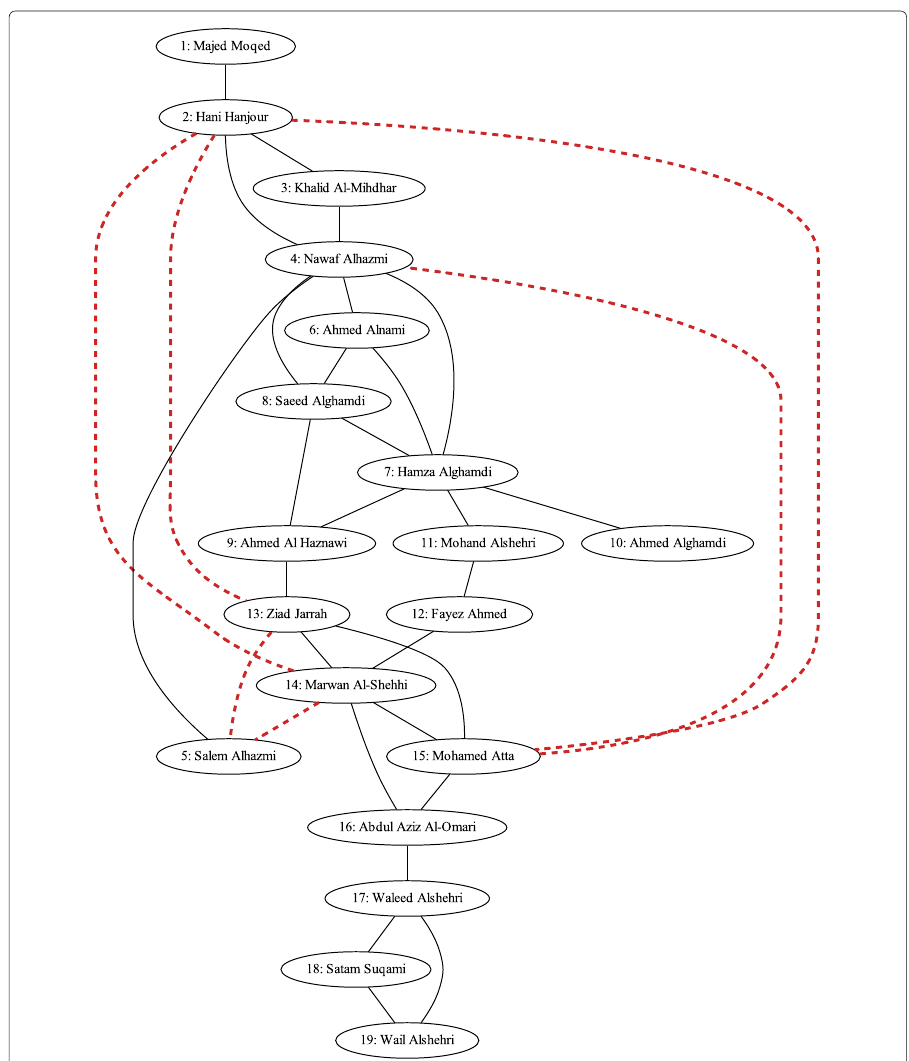
Fig. 18 Krebs 2001 terrorist network. To illustrate the augmented terrorist network–the result of additional meetings–red dashed lines were